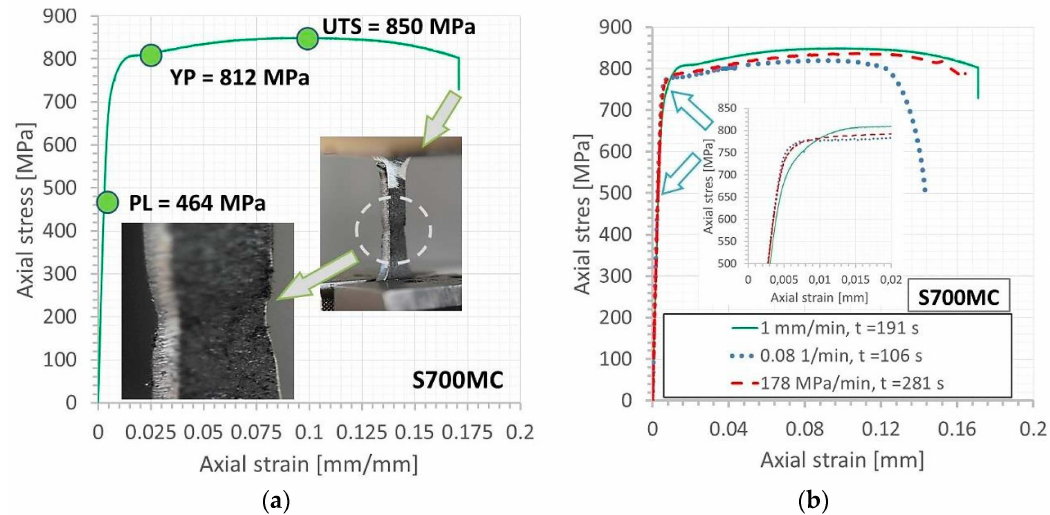
Figure 7. Tensile characteristics of S700MC steel from tests conducted at various loading signals at the following values of velocity for: ( a ) displacement 1 mm/min, ( b ) strain—0.08 1/min.